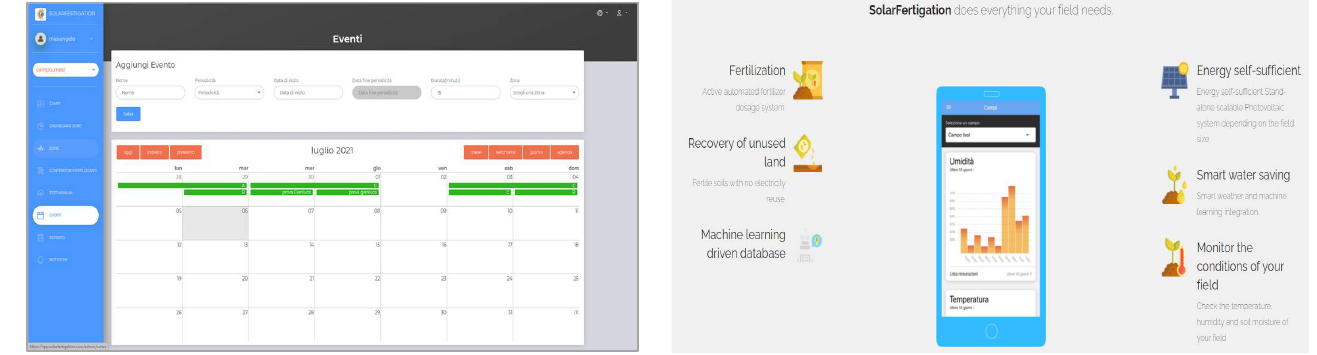
Figure 3. Web-based platform for irrigation monitoring.